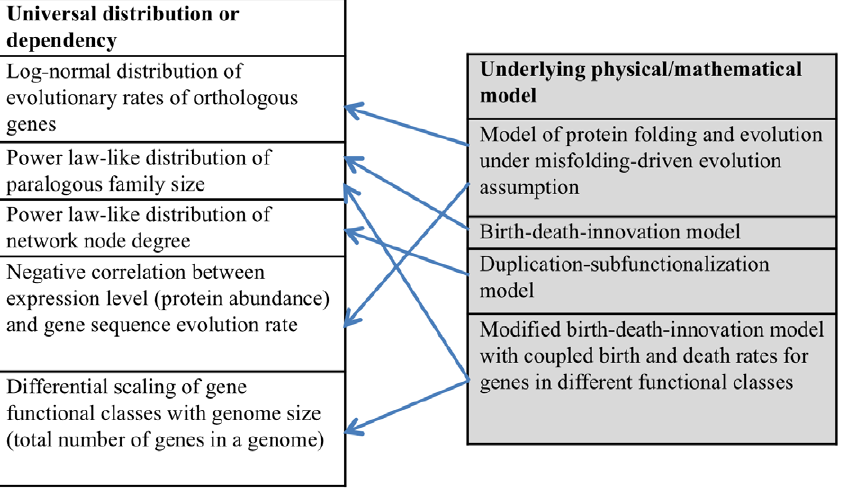
Figure 2. Universals of genome and molecular phenome evolution and underlying physical/mathematical models. Arrows connect each model with the universals it accounts